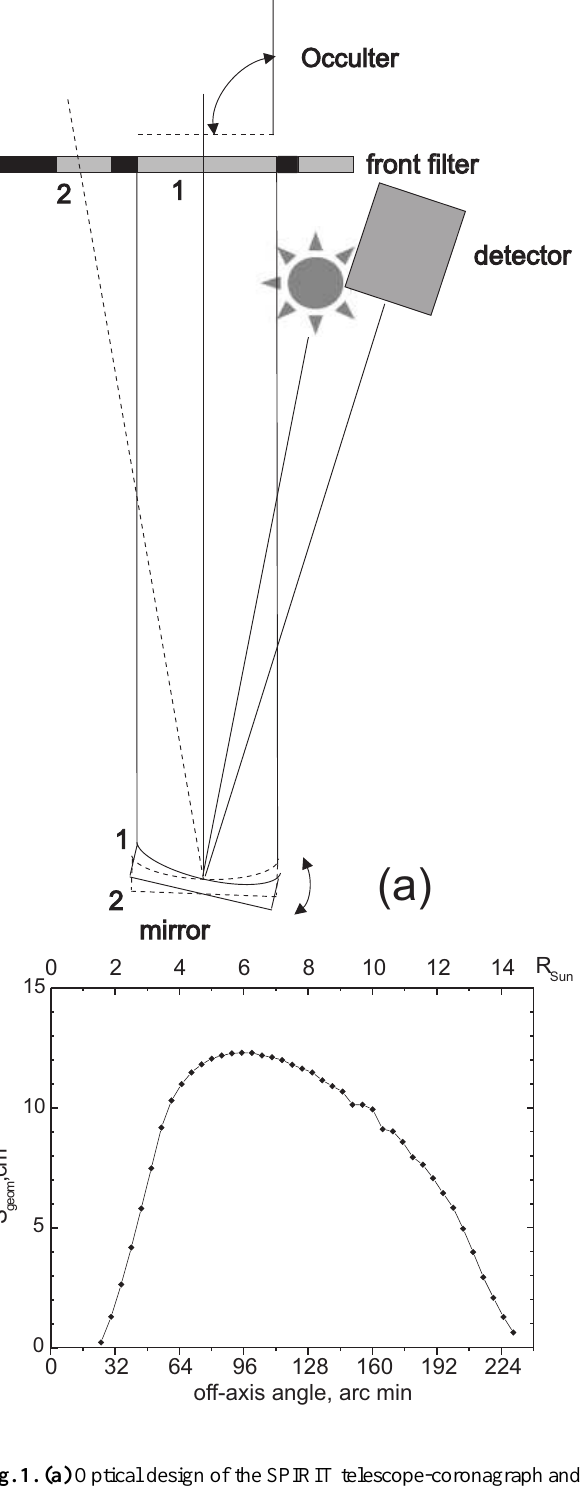
Fig. 1. (a) Optical design of the SPIRIT telescope-coronagraph and the ray paths in the disk mode (1) and in the coronagraphic mode (2); (b) the geometrical area of the coronagraph versus the off-axis angle (a vignetting function) with the closed occulter.